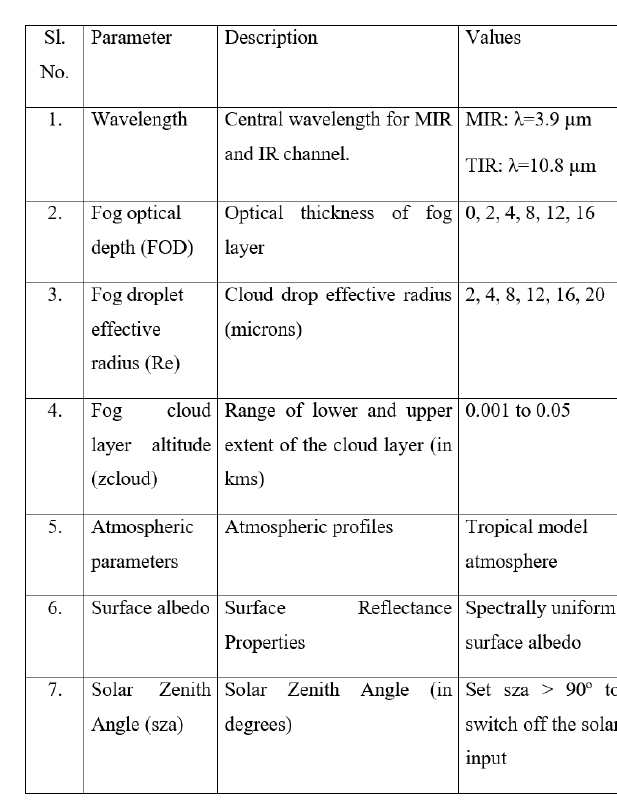
Table 2. Input parameters configuration for SBDART